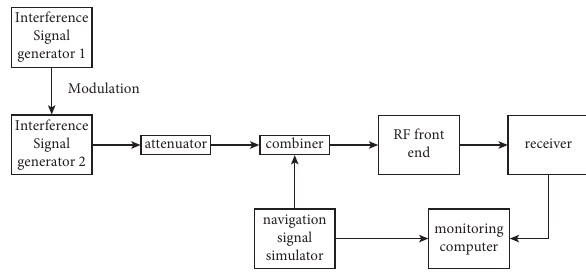
Figure 2: Block diagram of experiment configuration.